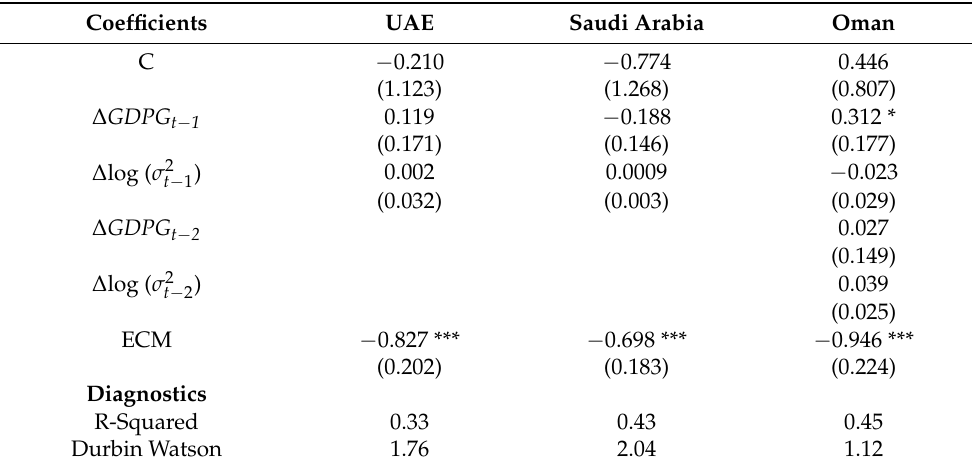
Table 6. Error correction model estimation